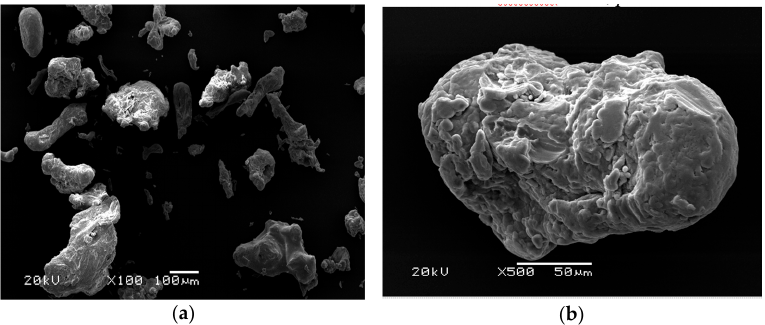
Figure 1. SEM images of Alumix 431D powder ( a ) magnification ×100 ( b ) magnification ×500.